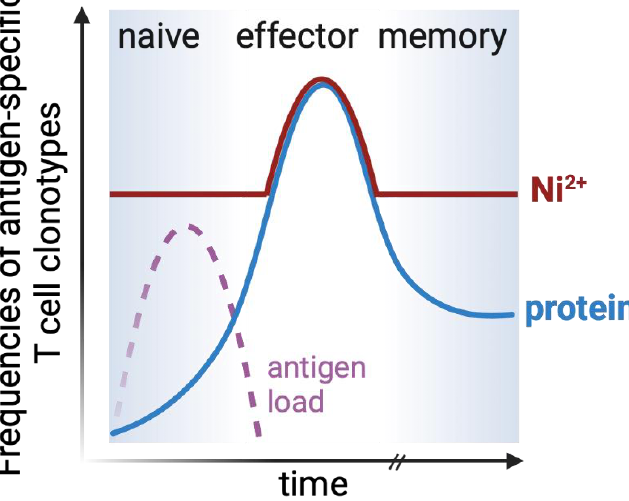
Figure 2. High frequencies of metal-specific T cells in blood interfere with diagnostic blood-based in vitro testing. Following adaptive immune responses, blood frequencies of protein-specific memory T cells are usually higher compared to those in the naïve T cell pool, even decades after antigen exposure (blue line). However, Ni-specific T cells are abundant in non-allergic individuals (red line), due to interactions with certain elements of the TCR repertoire (see Section 5.2) [115]. Therefore, only strongly increased frequencies of Ni-specific T cells may currently be associated with the allergic state. Adapted from [174]. Created with BioRender.com.